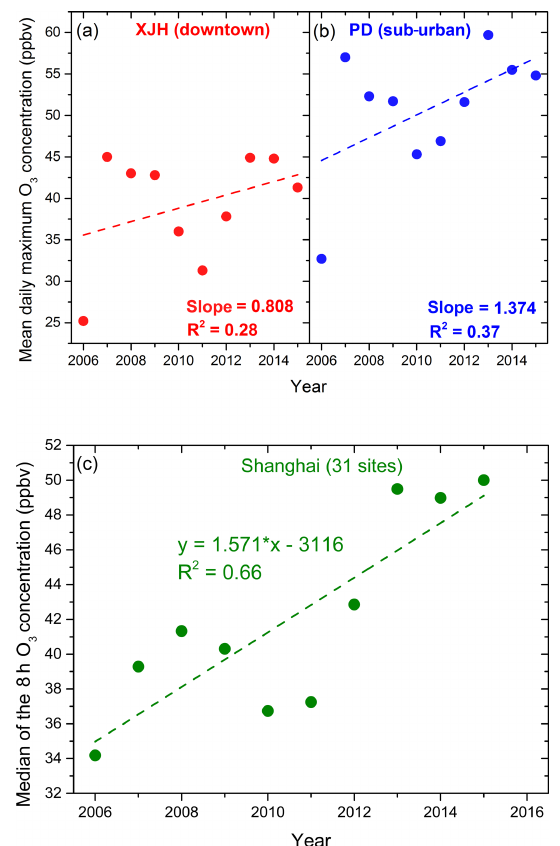
Figure 2. The annual variation in daily maximum O 3 concentra- tion (ppbv) from 2006 to 2015 at (a) the downtown site XJH and (b) the sub-urban site PD, both presenting significant increasing trends with 0.808ppbvyr − 1 at XJH and 1.374ppbvyr − 1 at PD re- spectively. The variation in the median 8h O 3 concentration (ppbv) from 2006 to 2015 averaged for 31 sites over Shanghai (c) also shows the increasing variability of 1.571ppbvyr − 1